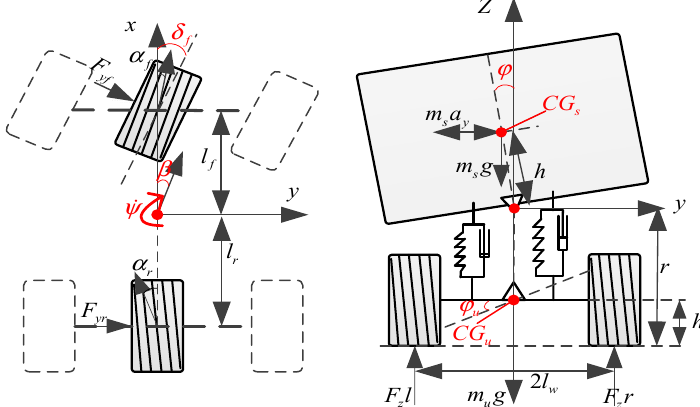
Figure 2. The four-degree-of-freedom commercial vehicle model.